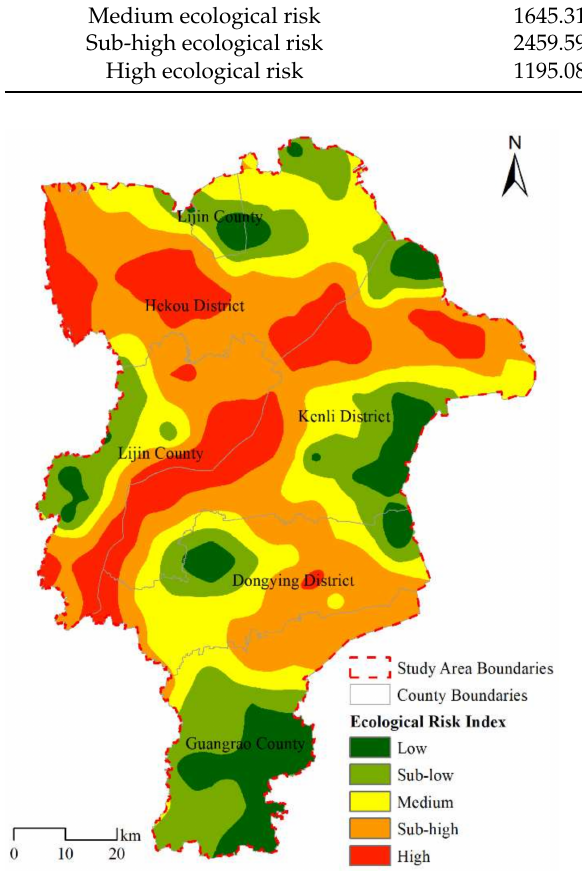
Figure 4. Spatial distribution of landscape ecological risks in Dongying City.